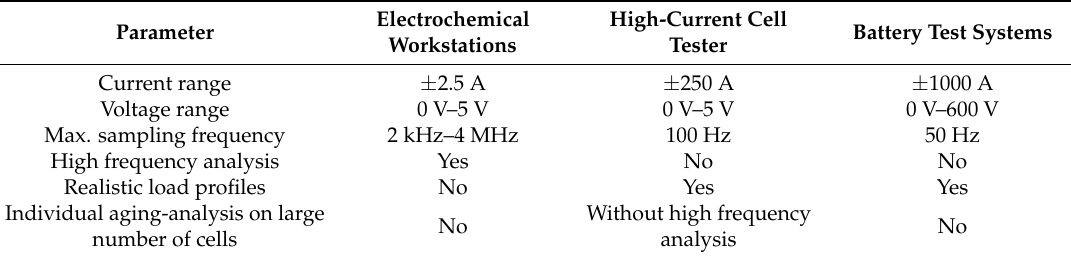
Table 1. Performance data of typical test system